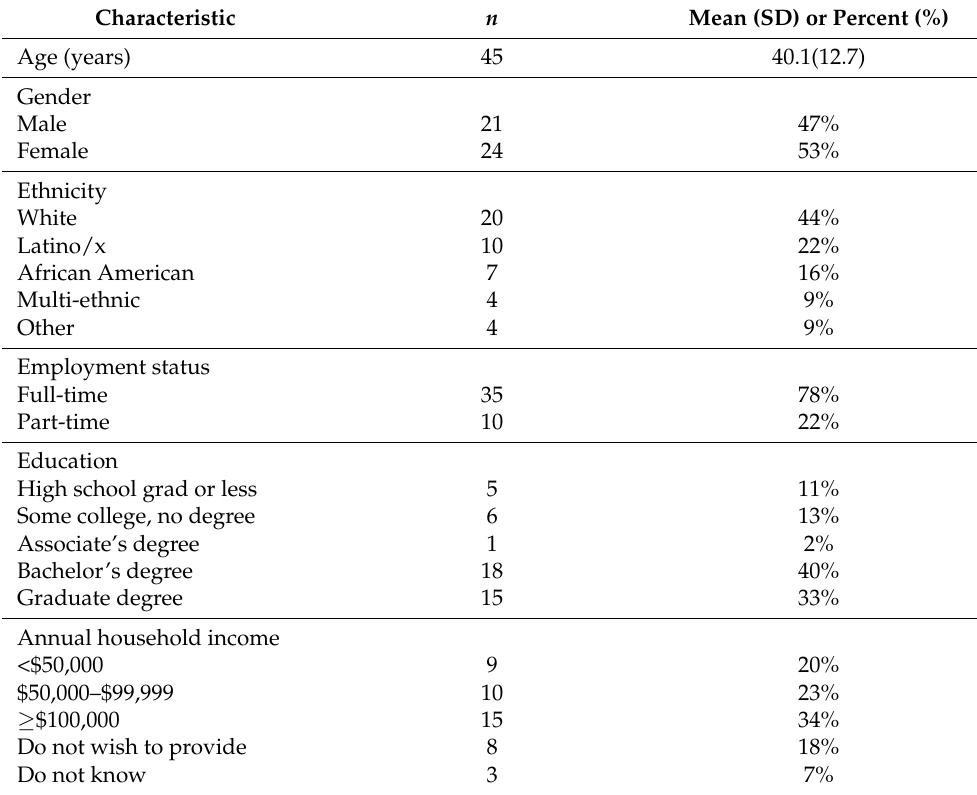
Table 3. Demographic characteristics of our working sample ( n = 45).